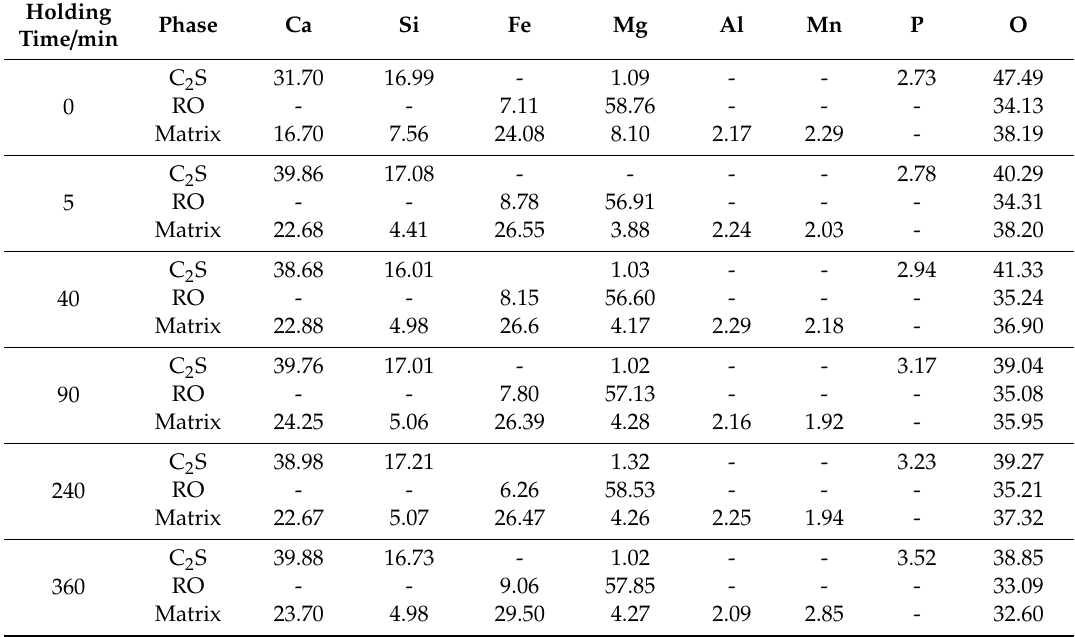
Table 2. EDS analysis of the modified slag with di ff erent holding times at 1673 K (at%).